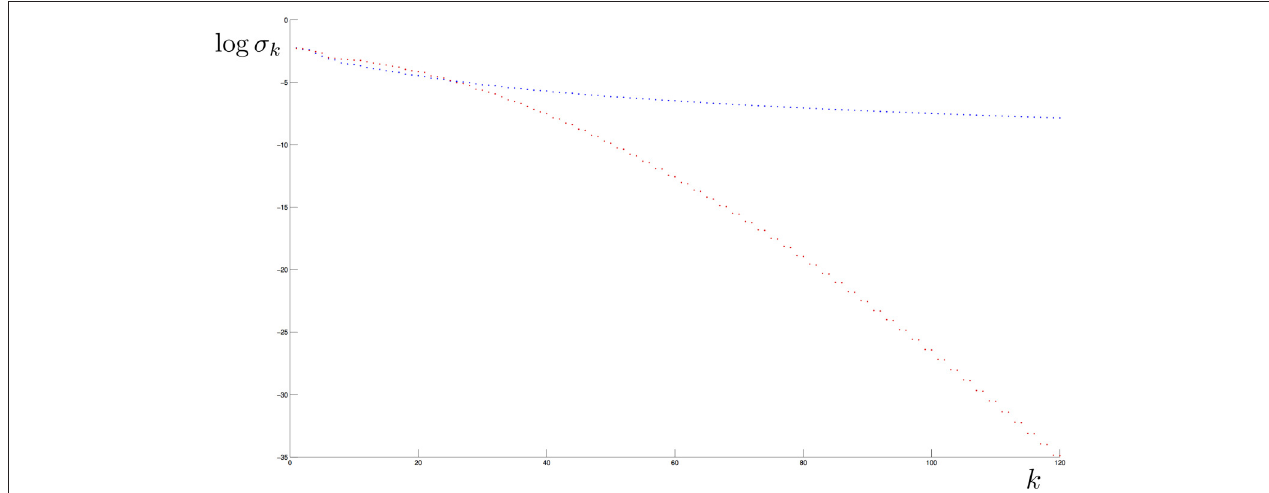
FIGURE 1 | Eigenvalues in logarithmic scale of the Covariance operator when the kernel is Abel (blue) and Gaussian (red) and the distribution is uniformly supported on the “8” curve in Figure 2 . Note that the eigenvalue decay rate of the first operator has a polynomial behavior while the second has an exponential